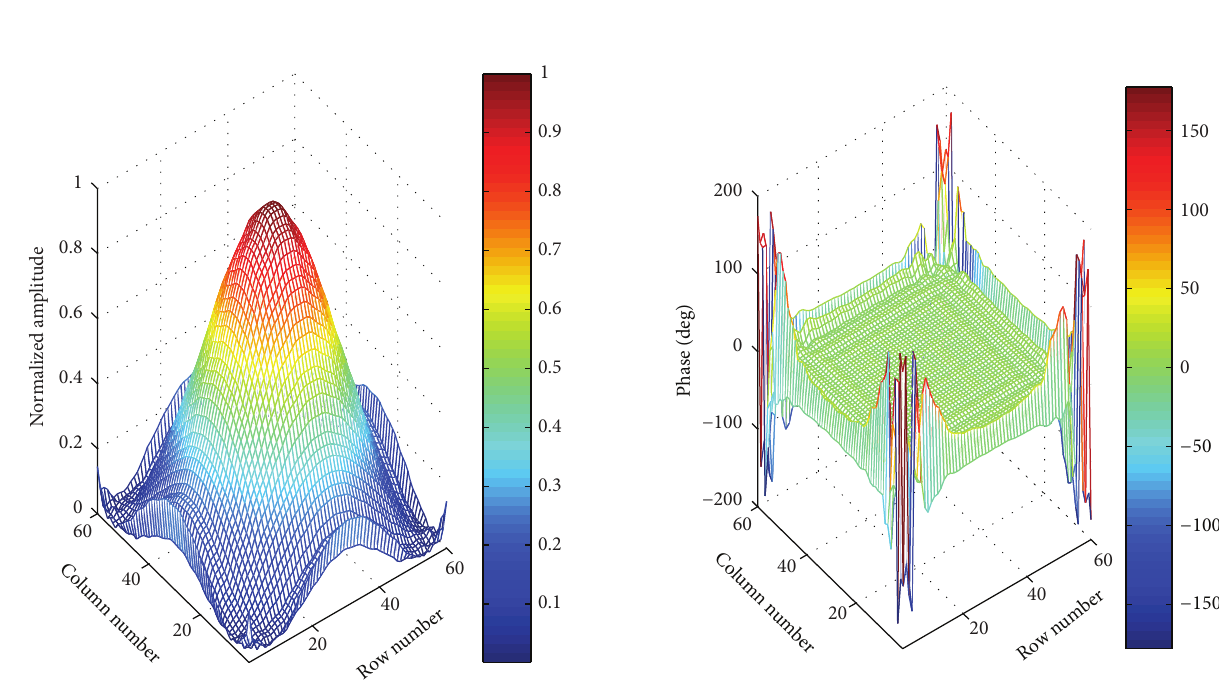
Figure 11: Normalized amplitude and phase of the